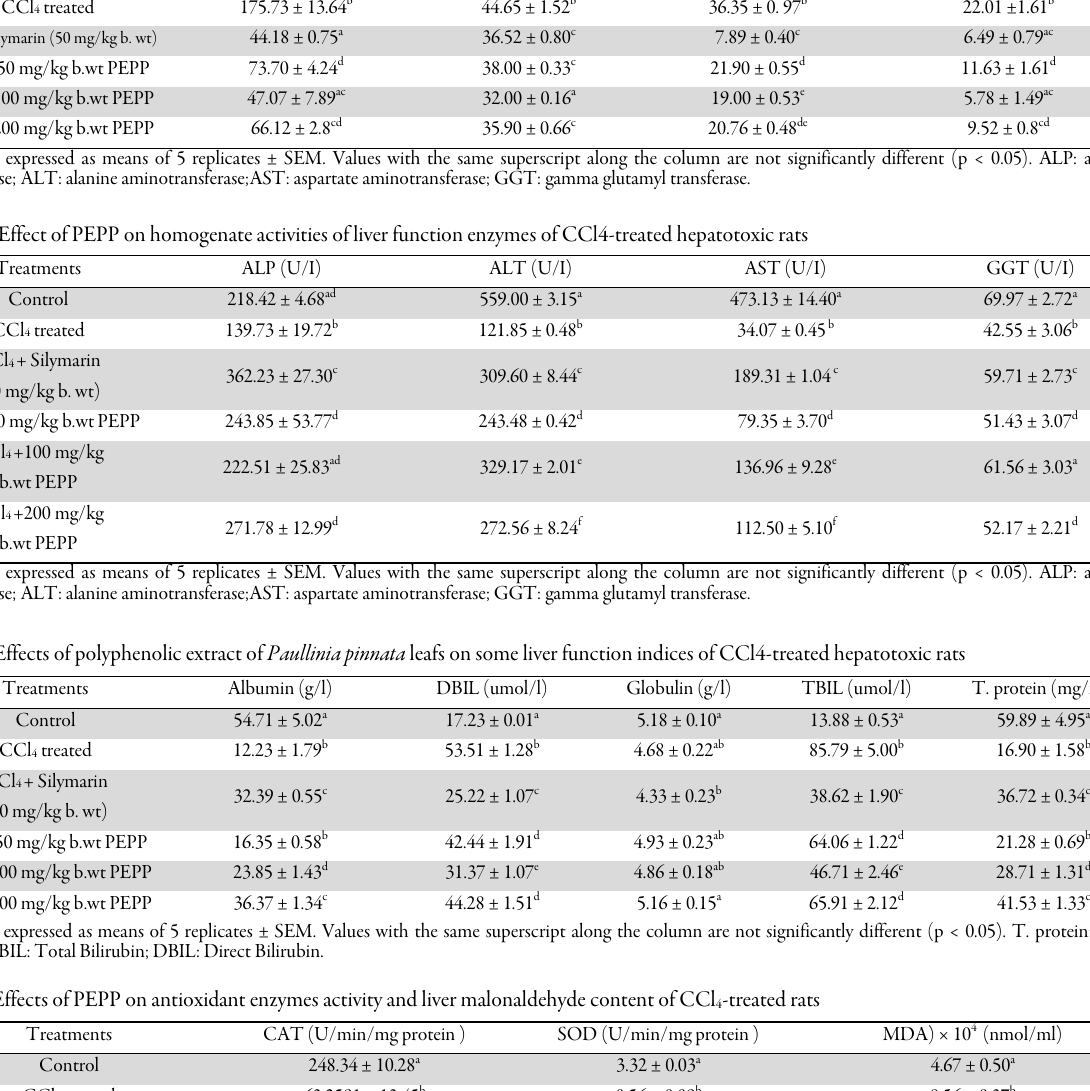
Table 2. Effect of PEPP on serum activities of liver function enzymes of CCl4-treated hepatotoxic rats Treatments